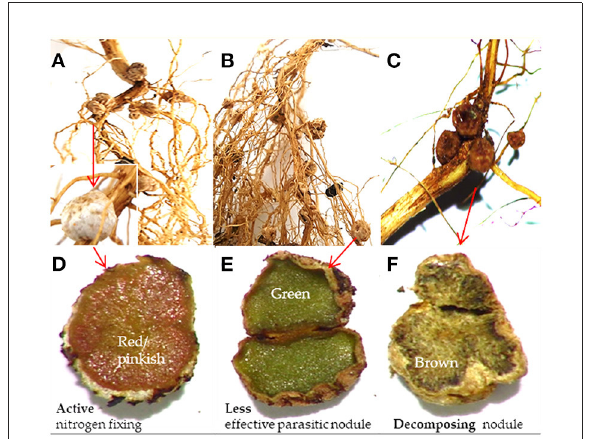
FIGURE4 Soybean plants with nodulated roots. (A) Healthy nodules on soybean plants used as a control plants. (B) Roots of moderated water-stressed plant with numerous mature nodule structures. (C) Severe water-stressed plant root showing poor nodulation. (D) Nitrogen (N) fixing nodules with Rhizobia as observed in the control. (E) Green less-effective nodules from moderately water-stressed roots. (F) Decomposing root nodule of severely water-stressed plants (Mangena,